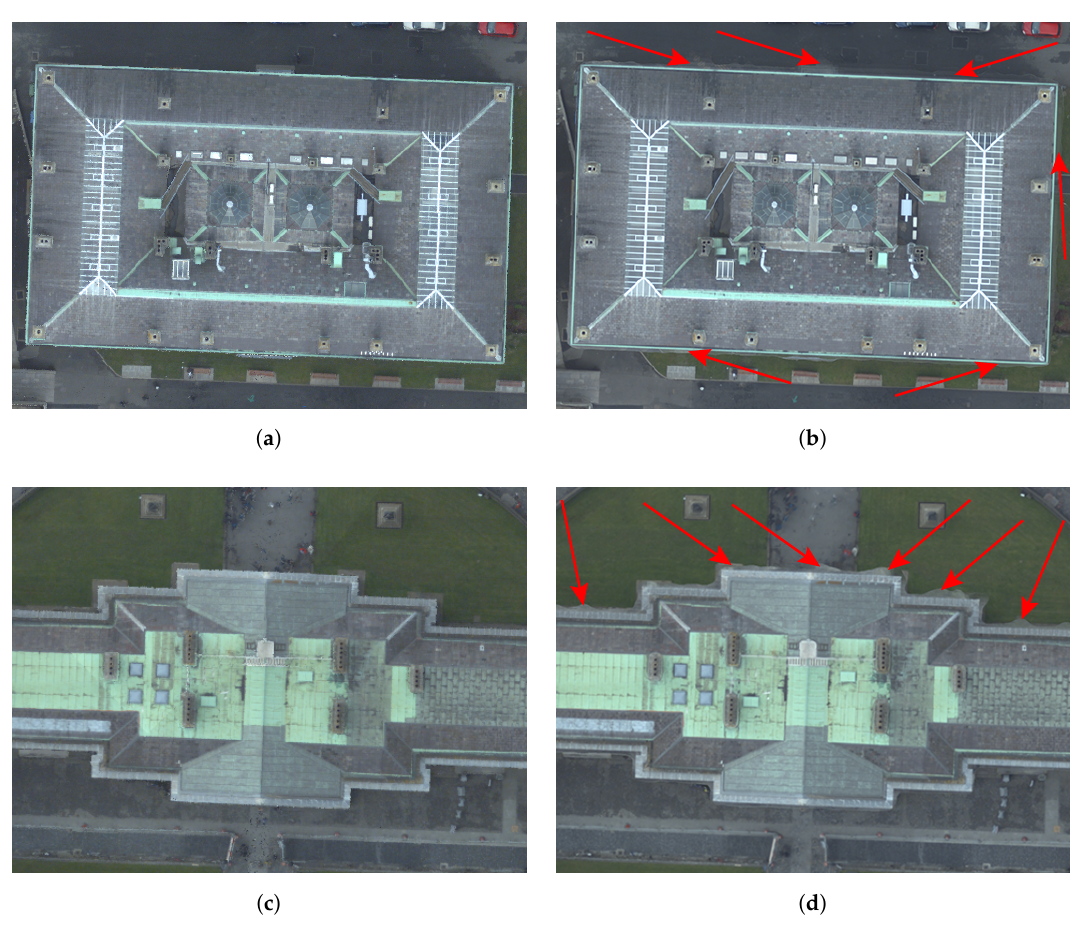
Figure 23. ( a ) A portion of the LiDAR-based true orthophoto, and ( b ) image-matching-based true orthophoto for the same area; ( c ) Another part of the LiDAR-based true orthophoto, and ( d ) the corresponding image-matching-based true orthophoto. Pixel size is equal to 10 cm in the